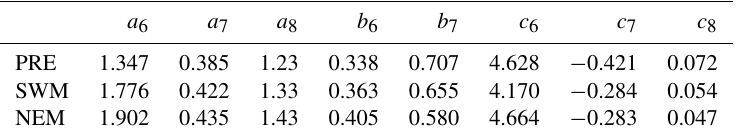
Table 4. Coefficients of D m and N W retrieval equations.